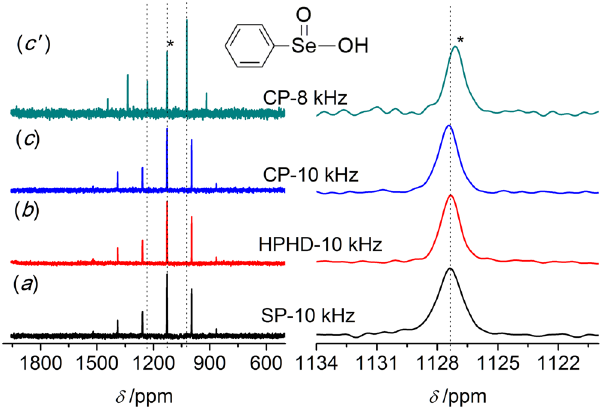
Figure 3. 77 Se MAS NMR spectra of PhSeO 2 H 2 obtained by different pulse sequences. ( a ) Single pulse (SP); ( b ) High power 1 H decoupling (HPHD); ( c, c ′ ) Cross polarization (CP), 1200 scans and the spinning speed of 8 kHz or 10 kHz. The isotropic peak is labeled with an asterisk ( * ).